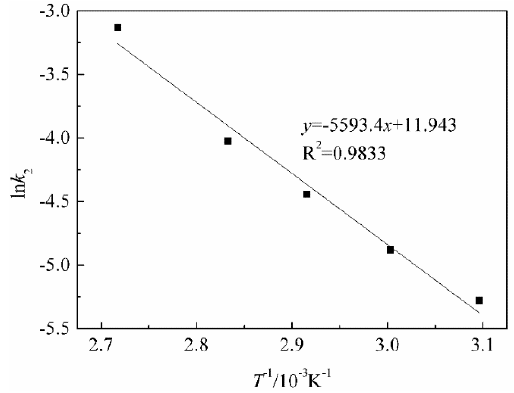
Figure 19. Arrhenius fitting plot of ln k 2 as a function of 1/(1000 T ) .